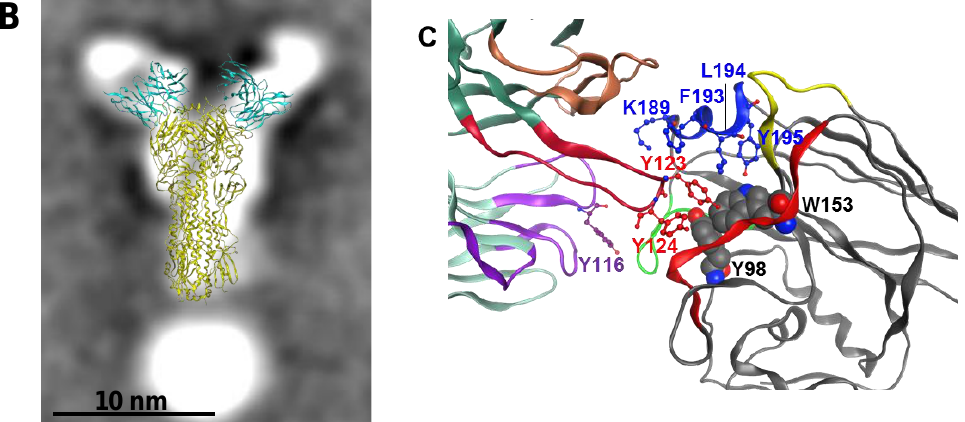
Figure 5. Effect of HA RBS point mutations on A2.91.3 binding determined by FACS analysis. ( A ) AHK14 HA mutants were evaluated by Sf9 expression and FACS dual staining with stem antibody CR8020 for gating of HA expression and A2.91.3 labeling for binding analysis. Mutations in the 190-helix show a significant loss of binding to RBS antibody A2.91.3. ( B ) The antibody angle of approach as visualized by TEM 2D class averaging images was used to screen the models of A2.91.3 Fv binding to the RBS of AHK14 HA. ( C ) The model of A2.91.3 binding to the RBS identified the HC CDR3 loop (red) interacting directly with the RBS pocket. The HC CDR2 (orange) and CDR3 (red) are in contact with the 190-helix, and LC CDR3 loop (purple) interacts with the 220 loop (green) of the RBS and neighboring protomer glycans.